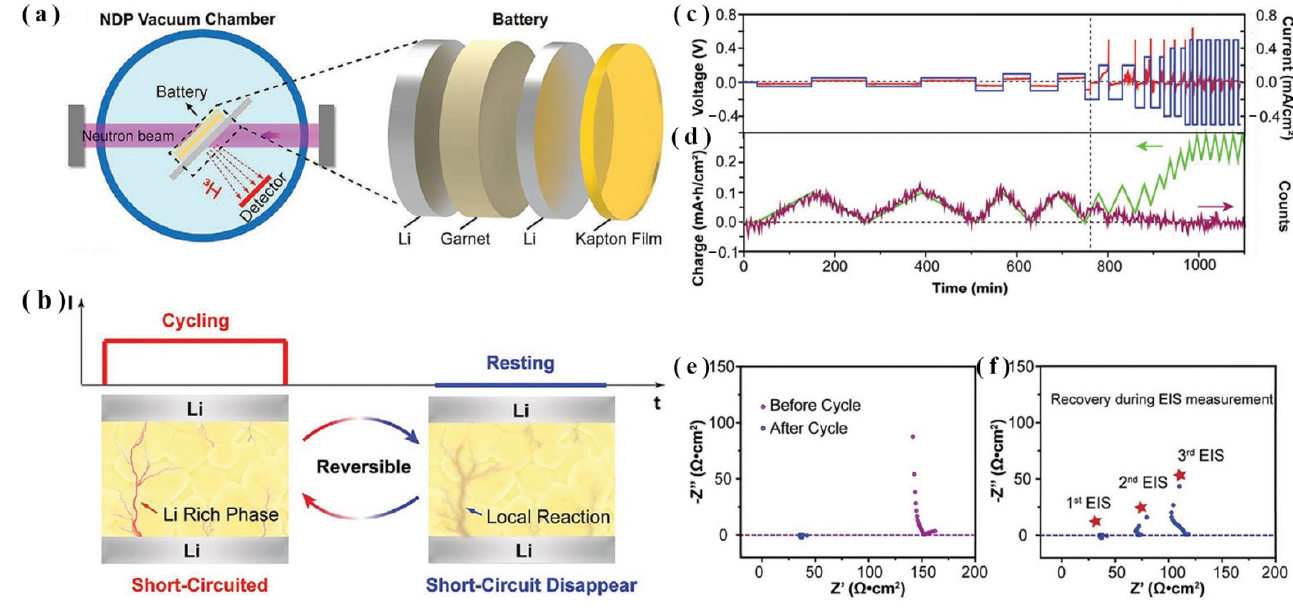
Figure 12. Schematic of ( a ) in situ NDP set-up for quantitative Li monitoring, ( b ) symmetric Li/LLZTO/Li all-SSLBs with reversible short-circuit behavior, ( c , d ) in situ NDP quantification of a Li/LLZTO/Li symmetric all-SSLB cycling at various current densities, ( e , f ) pre-NDP and post-NDP impedance spectra of the Li/LLZTO/Li cell and EIS quantifications recovery after NDP cycling (adapted with permission from Ref. [42]. 2020, Wiley-VCH).